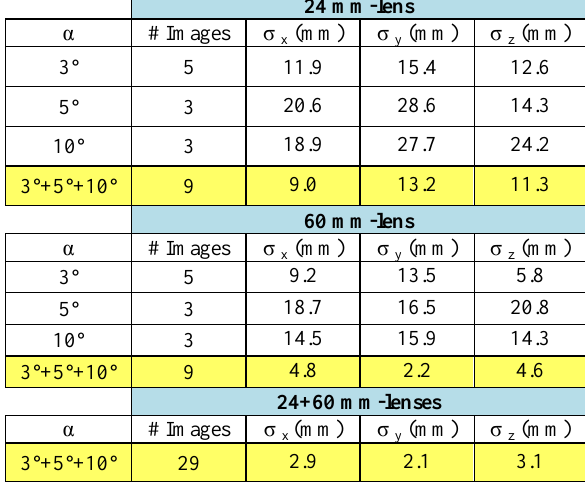
Table 1. Accuracy assessment of image orientation